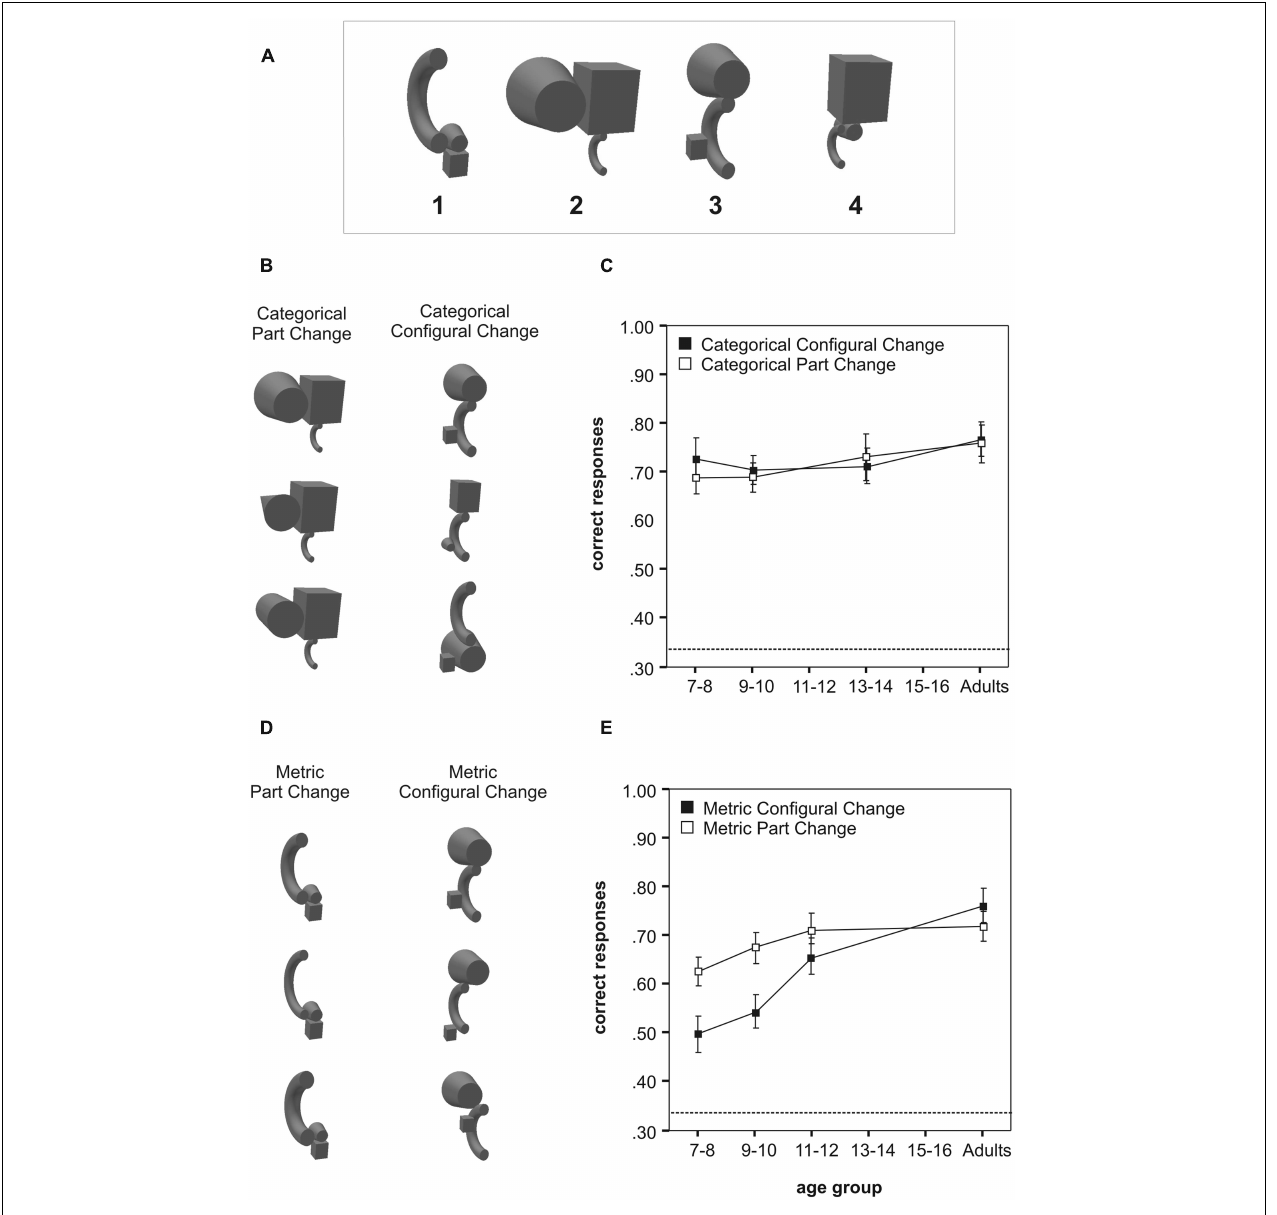
FIGURE 1 | Development of configural and part-based object recognition for manipulations at categorical and metric level (adapted from Jüttner et al., 2014). (A) Examples of multi-part objects used in the learning set of Jüttner et al. (2014). Participants were first trained to associate each object with its label (here: the number) during the learning phase of the experiment. (B) Examples of multi-part objects used to compare recognition performance for manipulations at categorical level. In each trial of the recognition test, a target object of the learning set (here for illustration purposes always shown in the top row) was presented with two distracters (middle and bottom row). The distracters differed from the target in terms of either a categorical part change (left) or a categorical, configural change of relative part position (right). Participants had to choose the correct depiction of the previously learnt object. (C) Mean recognition accuracies as a function of age for the categorical part change and categorical configural change condition. (D) As in (B) but examples show multi-part objects used to compare recognition performance for manipulations of parts and part relations at metric level. (E) Mean recognition accuracies as a function of age for the metric part change and metric configural change condition. Error bars are standard errors. The dashed line at 0.33 indicates chance level.